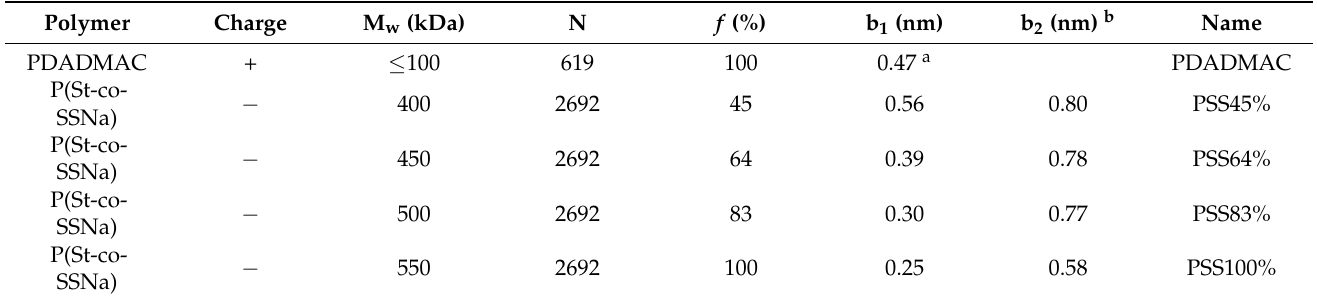
Table 1. Characteristics of the PEs investigated in this work: charge, weight-average molecular weight (M w ), degree of polymerization (N), chemical fraction of sulfonated units ( f ), charge spacing based on the monomer size (0.25 nm) (b 1 ), mean nearest-neighbor distance of sulfonate groups based on the radial distribution function of sulfur atoms of P(St-co-SSNa) (b 2